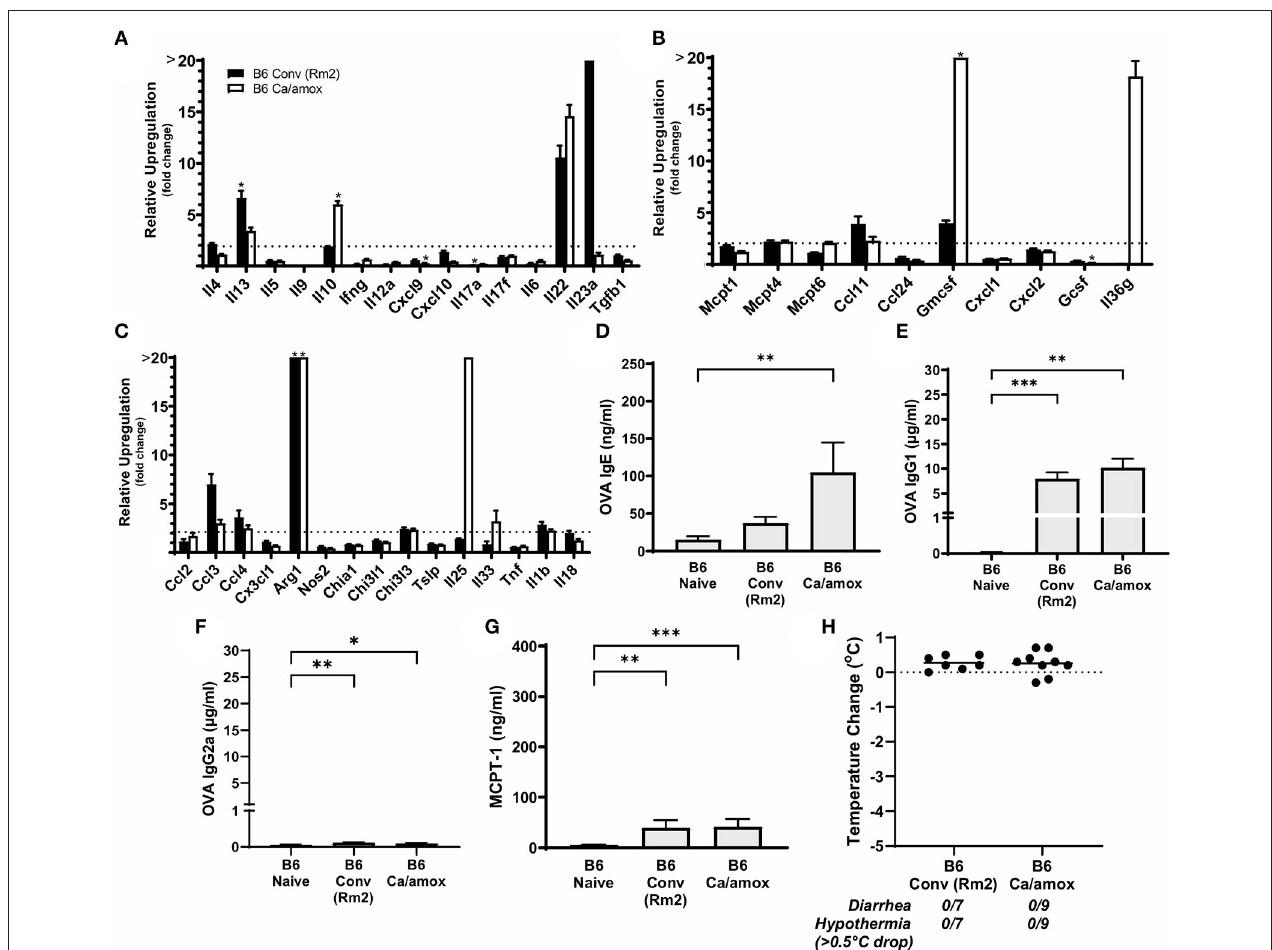
FIGURE 7 | Systemic anaphylaxis markers and cytokine gene induction for C57BL/6 mice tested for environmental impact on the microbiome (B6 Conv Rm2) and microbiota disruption (B6 Ca/amox) after oral antigen exposure. Mice were treated as outlined in Figure 1A . (A-C) Cytokine expression shown is relative expression compared to naïve strain-matched mice. The dotted line indicates a two-fold upregulation from baseline expression levels. Gene expression was measured by qPCR. (D-G) The immunoglobulin and protease serum levels for (D) OVA-specific IgE, (E) OVA-specific IgG1, (F) OVA-specific IgG2a, and (G) MCPT-1. (H) Temperature drop was measured via rectal probe and the average maximum decrease from baseline was plotted. A single dot represents one mouse, and the bar is the group mean ± SEM. Refer to the materials and methods for a detailed description of analyses and statistical tests performed. Statistical significance: (A–C) (* P < 0.05) signifies significant upregulation in the treated compared to the untreated group for each gene (treated, n = 7-9, untreated, n = 5). P -values for (D–G) were determined with a Student’s t -test. Statistical significance is * P < 0.05, ** P < 0.01, and *** P < 0.001. Definitions of gene abbreviations can be found in Table 1